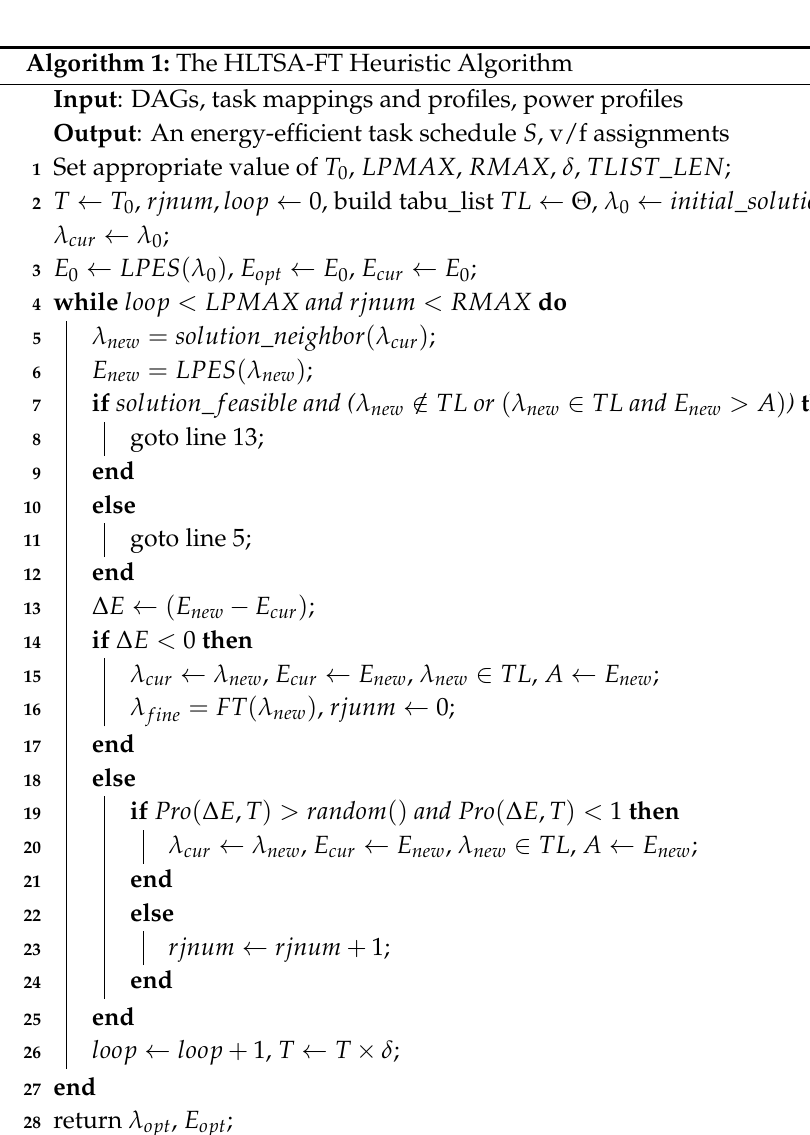
Algorithm 1: The HLTSA-FT Heuristic